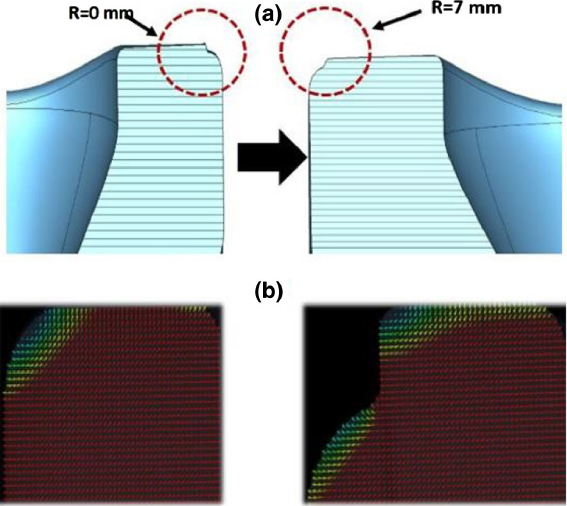
FIG. 31. Design modification in the SSR structure: (a) intro- duction of the double corner radius and (b) vector field plot in the multipacting zone before and after the introduction of the double corner